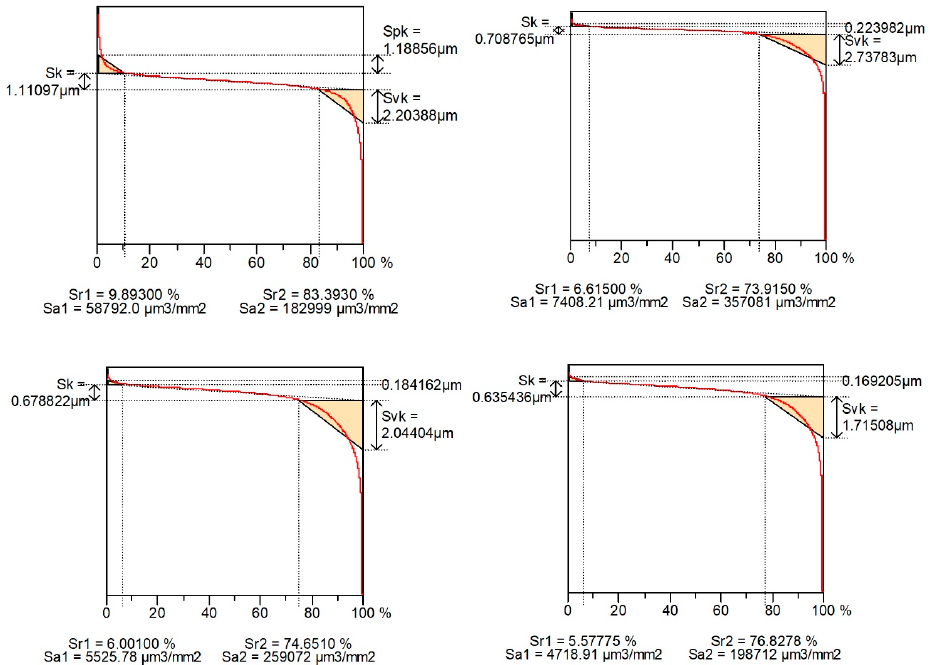
Figure 11. Material ratio curves of surfaces shown in Figure 10. Figure 12 presents selected dependencies between the surface parameters after abrasive blasting followed by lapping.